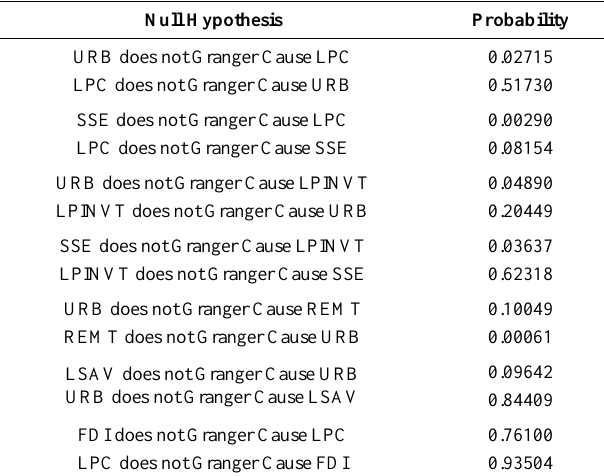
Table 4. Granger Causality